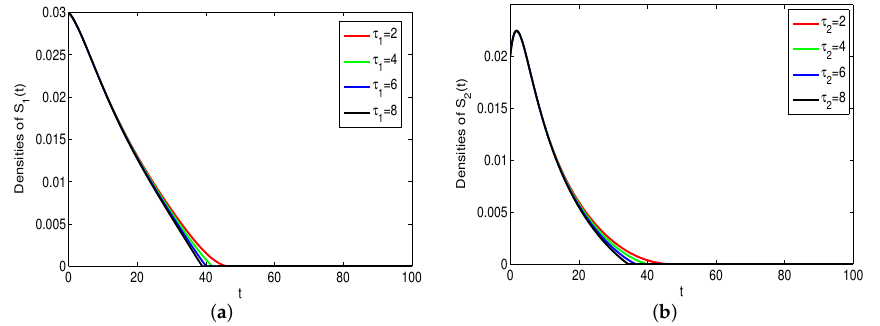
Figure 6. ( a ) The trajectories of S 1 ( t ) with different time delays. ( b ) The trajectories of S 2 ( t ) with different time